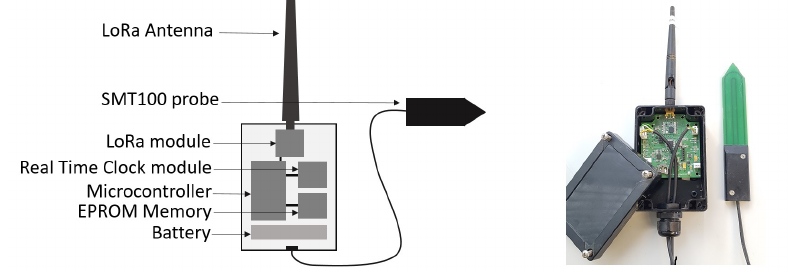
Figure 3. The sensor node is built around an Atmega328 microcontroller, a DS1378 temporal reference, a RFM95W LoRa radio module operating at 868-MHz, and an SMT100 probe. The radio antenna is out of the box and will be directly in contact with the